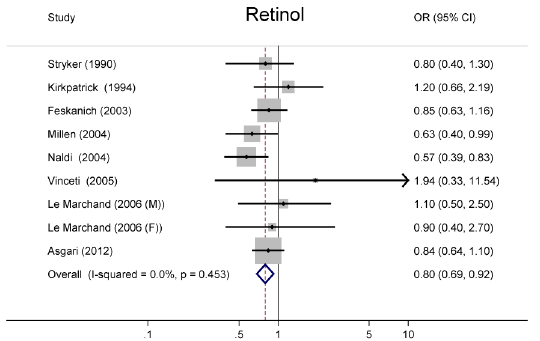
Figure 3. Odds ratios and 95% confidence interval of melanoma for the highest vs. lowest intake of retinol for individual studies and all studies combined.